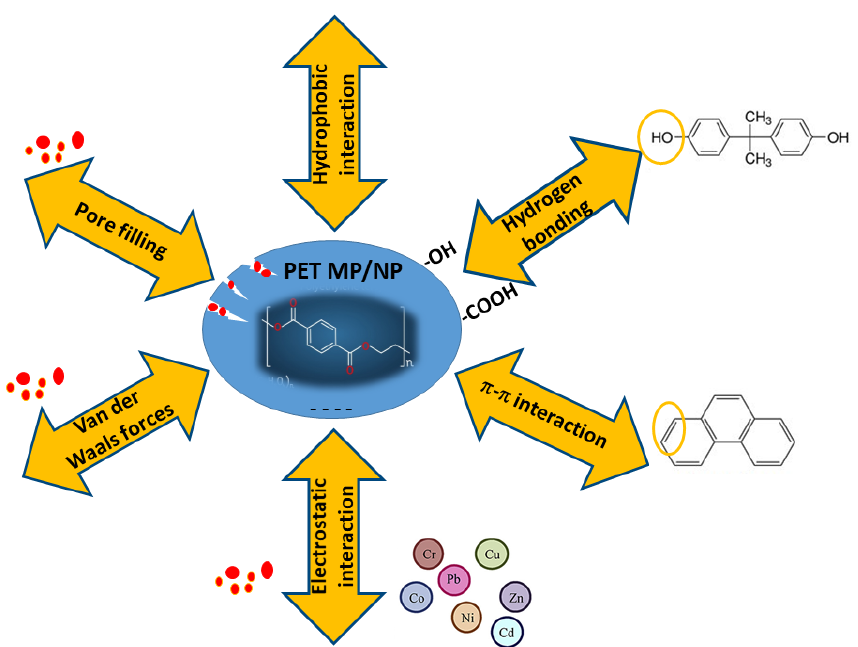
Figure 2. Typical sorption mechanisms between contaminants and micro- and nanoplastics (adapted from